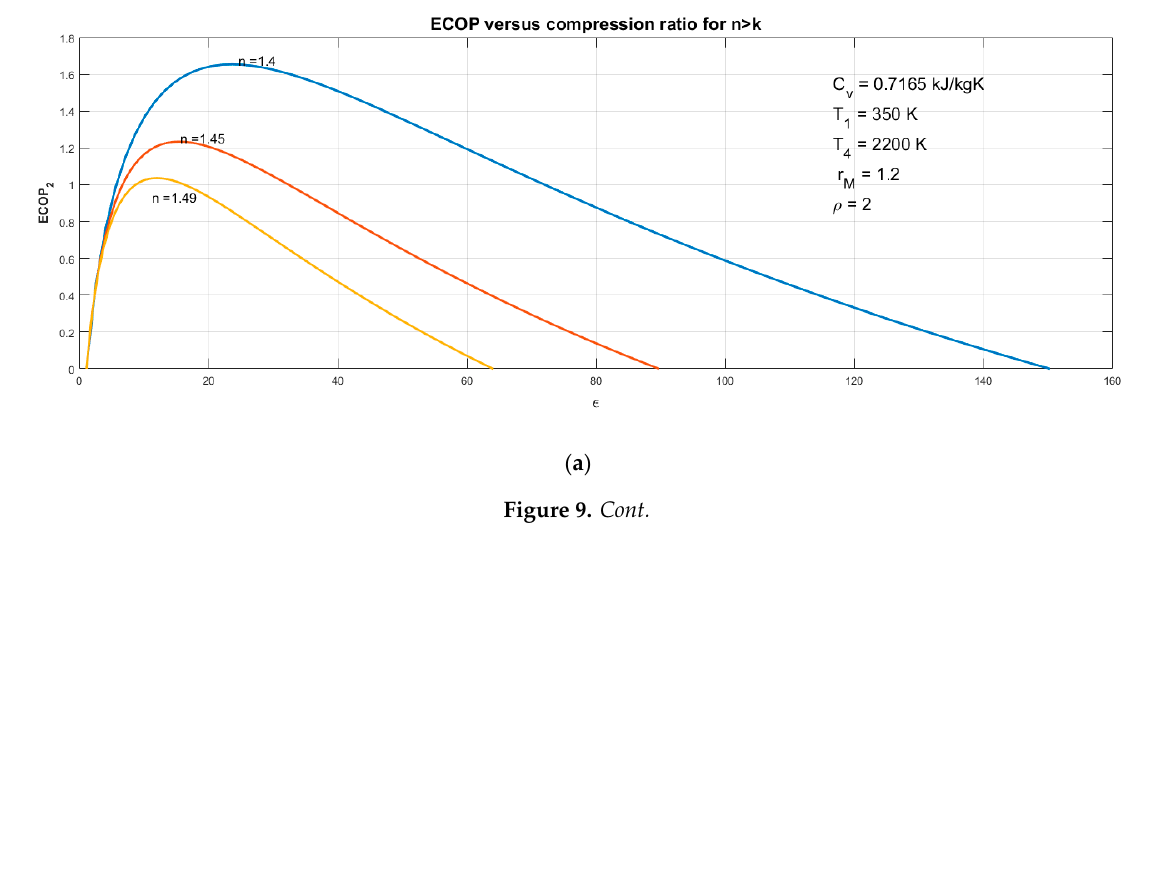
η 2 ( b ). Figure 8. Impact of n ( n > k ) on E un – P 2 ( a ) and E un – 𝜂 2 ( b ).